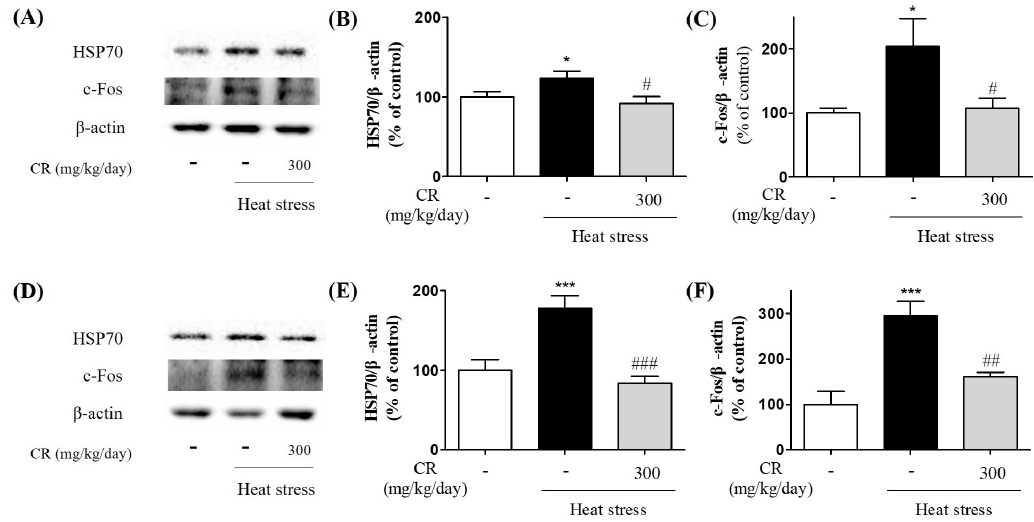
Figure 3. Inhibitory effects of CR against thermal stress-induced up-regulation of heat shock protein and activation of immediate early gene in the hypothalamus and hippocampus of mice. ( A , D ) Both HSP70 and c-Fos expressions were assessed using Western blotting with antibodies against HSP70 and c-Fos in hypothalamus and hippocampus, respectively. Quantification of densitometric analyses was performed by measuring the expression ratios of HSP70/ β -actin and c-fos/ β -actin in the lysates of hypothalamus ( B , C ) and hippocampus ( E , F ). Values are expressed as means ± SEM. * p < 0.05 and *** p < 0.001 as compared with the control group. # p < 0.05, ## p < 0.01 and ### p < 0.001 as compared with the heat-exposed vehicle-treated